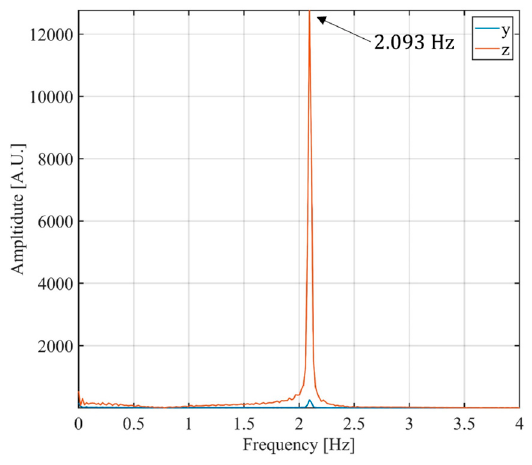
Figure 11. Natural frequency of target in Figure 7.